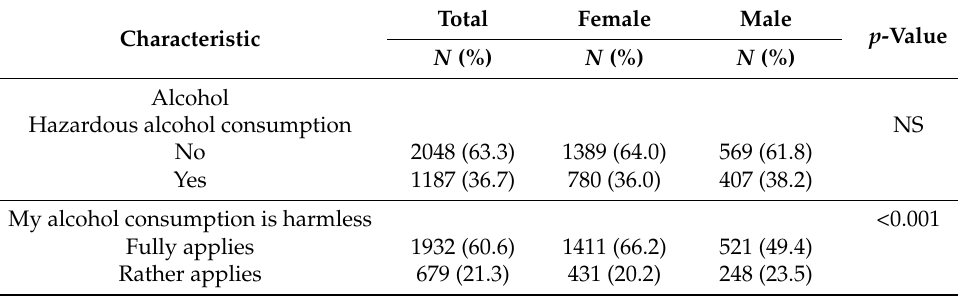
Table 5. Student alcohol, tobacco and substance use by